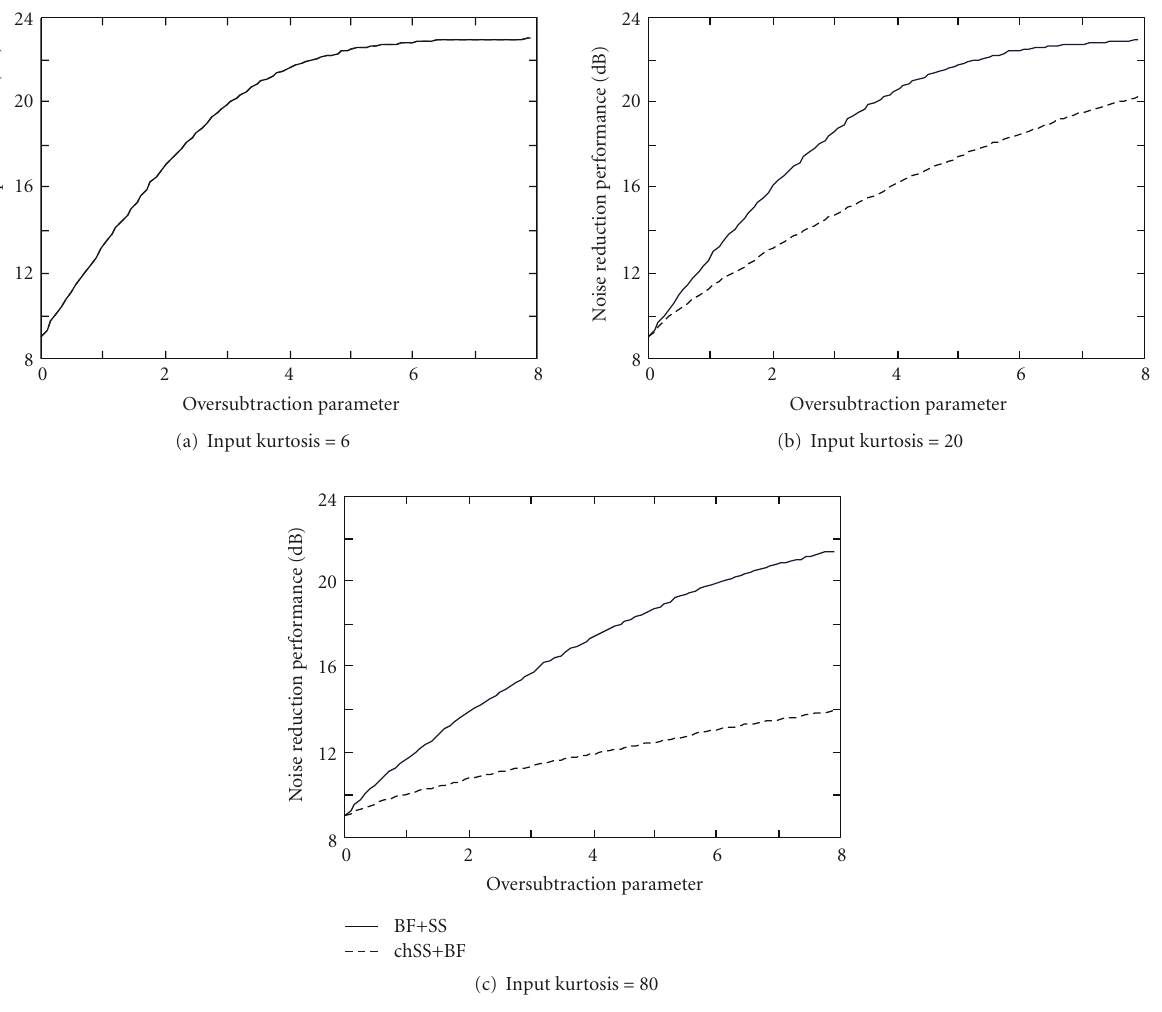
Figure 11: Comparison of noise reduction performances of chSS+BF with BF+SS. In this figure, flooring parameter is fixed to 0.2 and number of microphones is